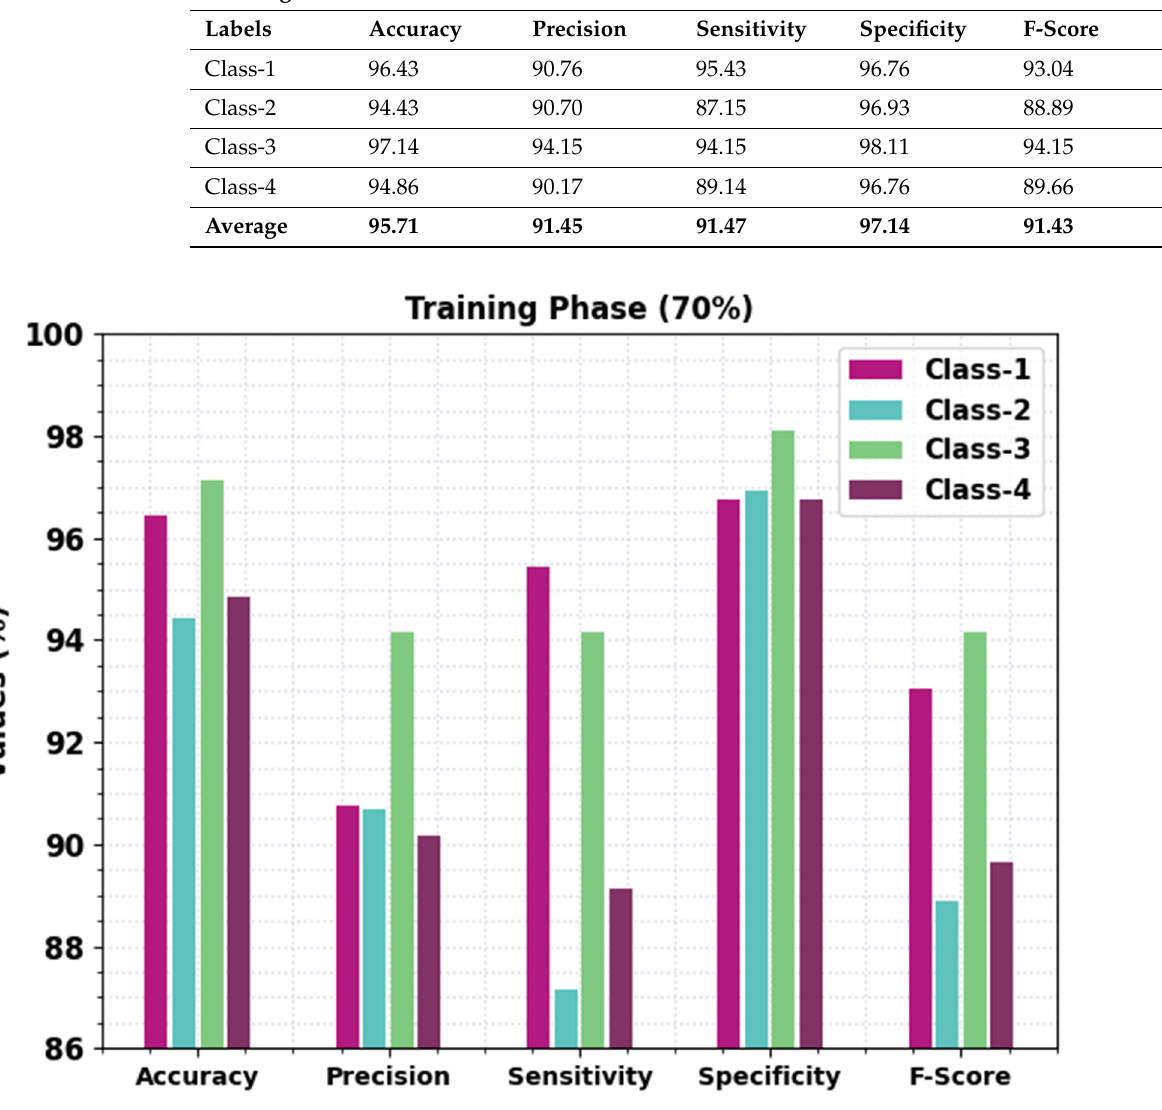
Figure 5. Crowd classification outcome of the AOTL-CDA3S system under 70% of the TR data- base.